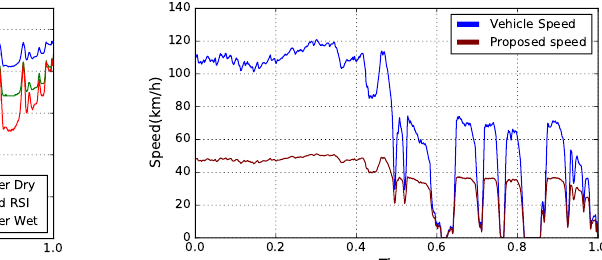
Figure 6. Urban driving scenario.